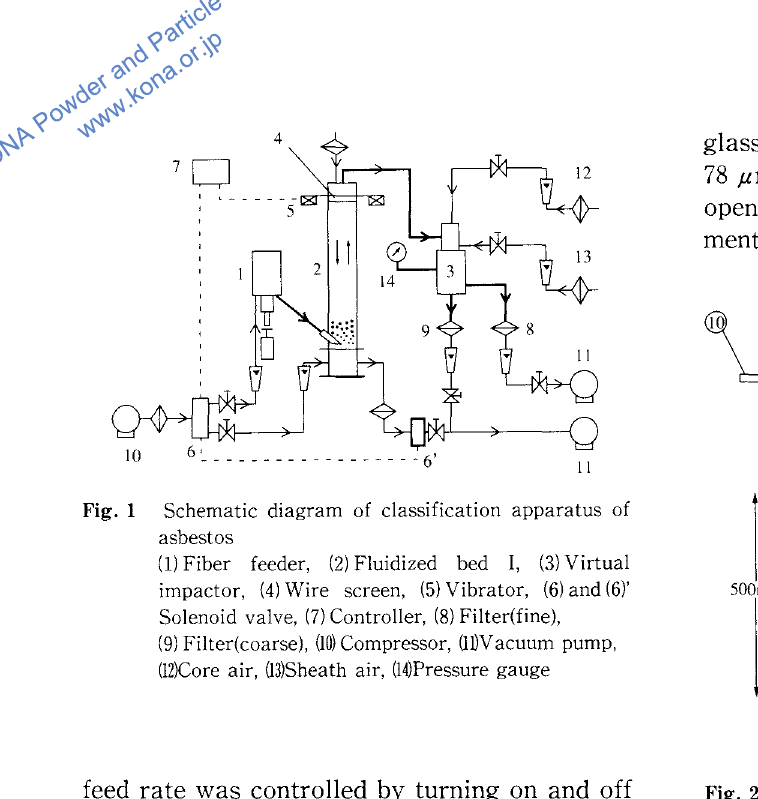
Fig. 2 Detail of Fluidized bed